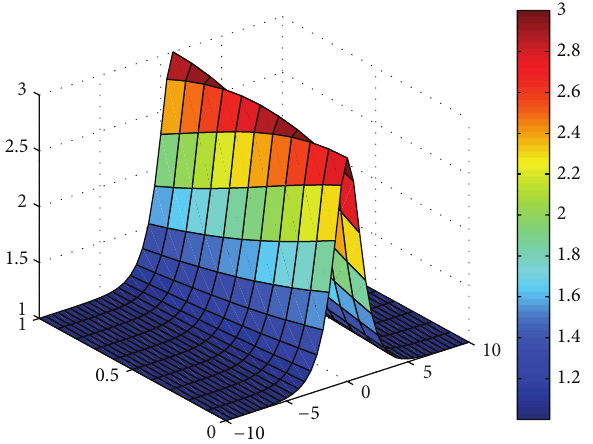
Figure 3: The solitary wave and behavior of the solutions 𝑢(𝑥,𝑡) = 1 + 2 sech (𝑥 − 𝑡) for 0 ⩽ 𝑡 ⩽ 1 and −10 ⩽ 𝑥 ⩽ 10 .